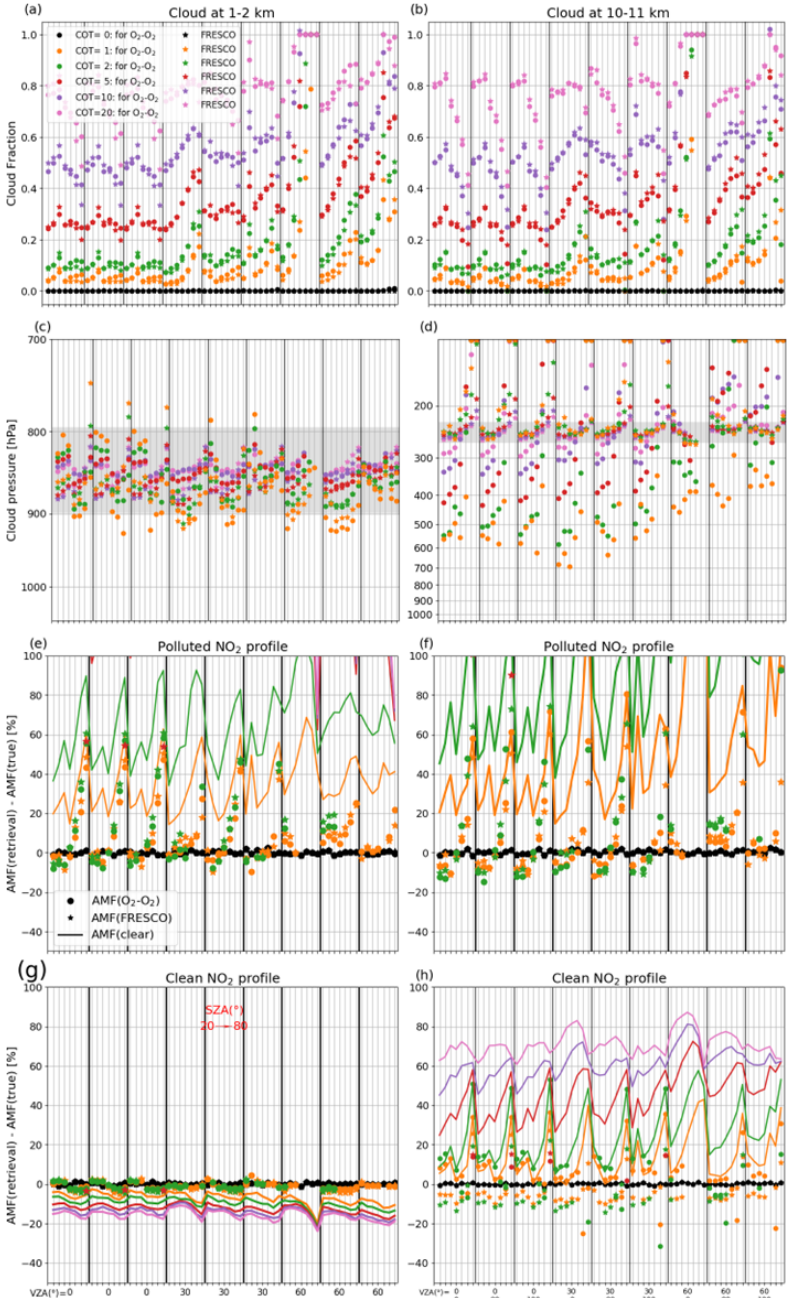
Figure A1. Examples of cloud and NO 2 retrieval for 1D cloud scenes, discussed in Sect. 2.5, with 1–2km (a, c, e, g) and 10–11km (b, d, f, h) cloud height. Panels (a) and (b) show O 2 –O 2 and FRESCO cloud fraction retrievals, and panels (c) and (d) are the cloud pressure retrieval from O 2 –O 2 and FRESCO cloud algorithms; the grey regions indicate the true cloud layer. Panels (e) – (h) compare the bias of the NO 2 AMFs using cloud correction based on O 2 –O 2 and FRESCO cloud products, as well as the AMFs without cloud correction, for polluted (e, f) and clean (g, h) conditions. The cloud correction is applied when the pixels with CF w are less than 50%. The x axis represents the cases with different geometries. The variety of colours represents the cases with different cloud optical